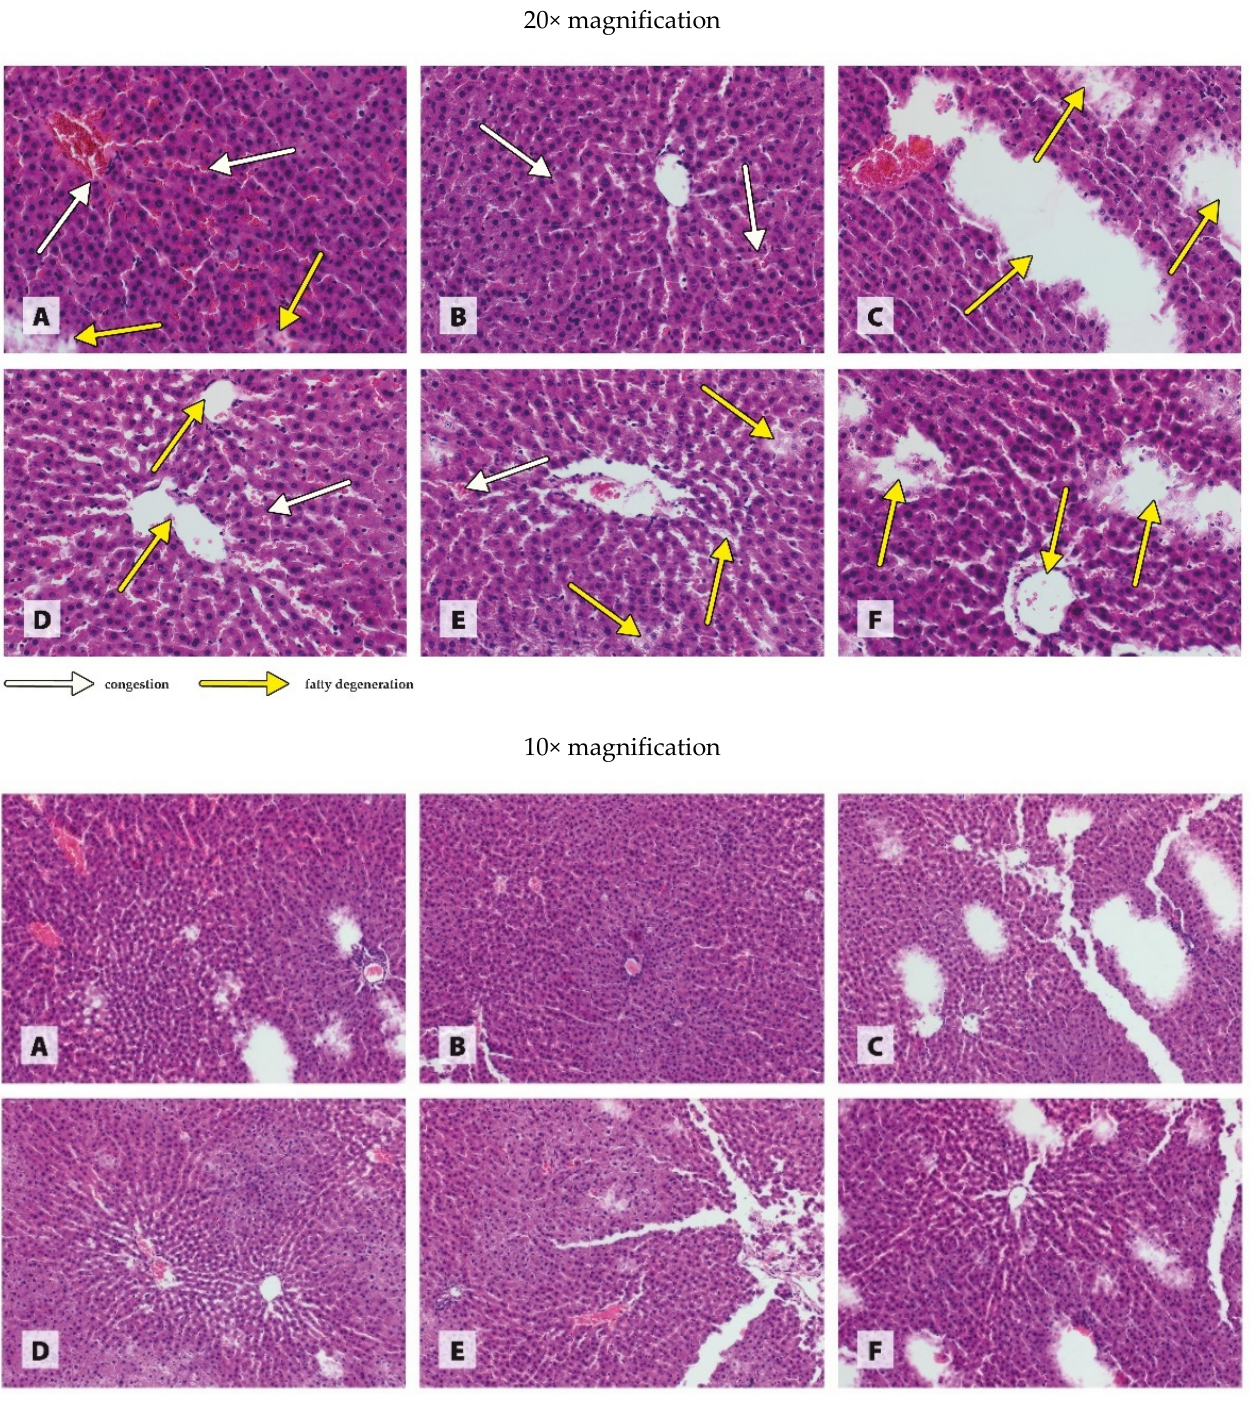
Figure 3. Morphological effects of different blood pressure and Cu sources on the liver of